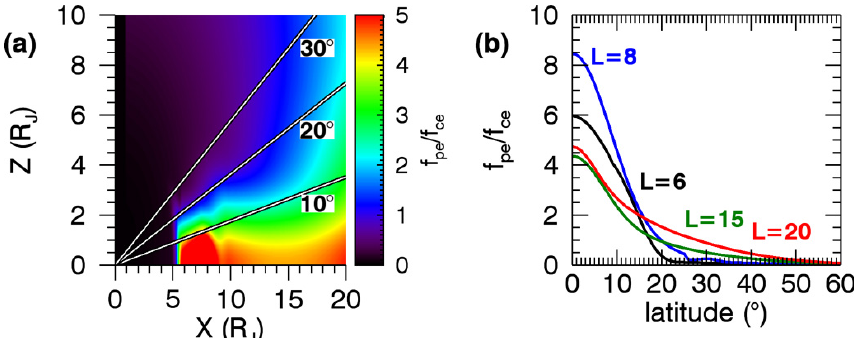
Fig. 2. Plots of f pe /f ce : (a) in the magnetic xz plane, with white on black lines showing 3 latitudes; (b) along selected magnetic L -shells.